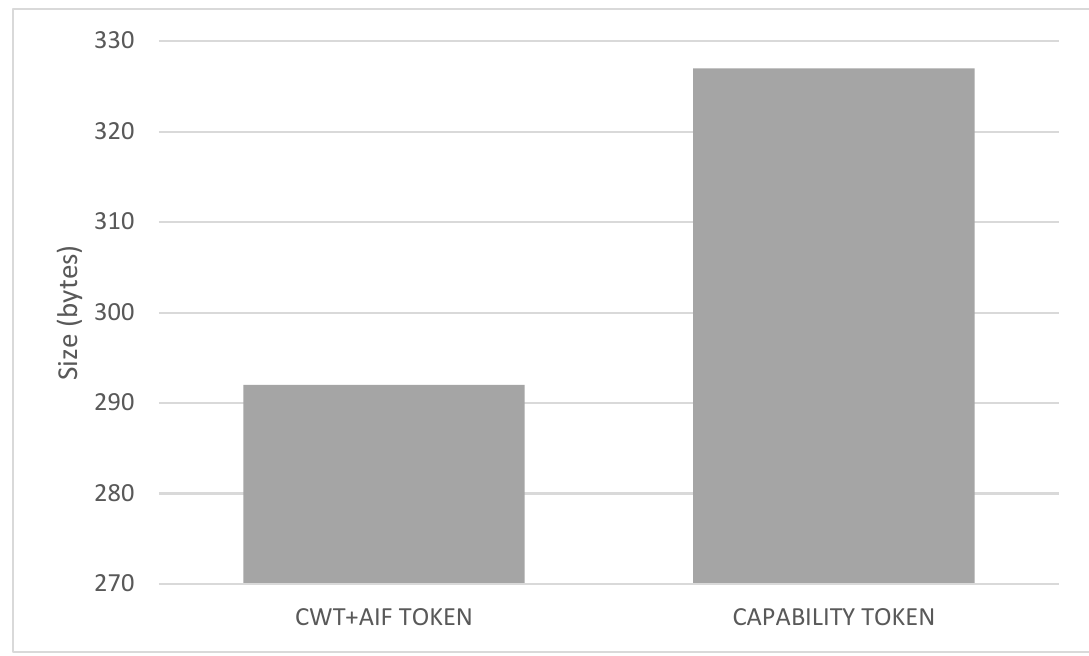
Figure 7. Overhead of our CWT-AIF token and the capability-based approach